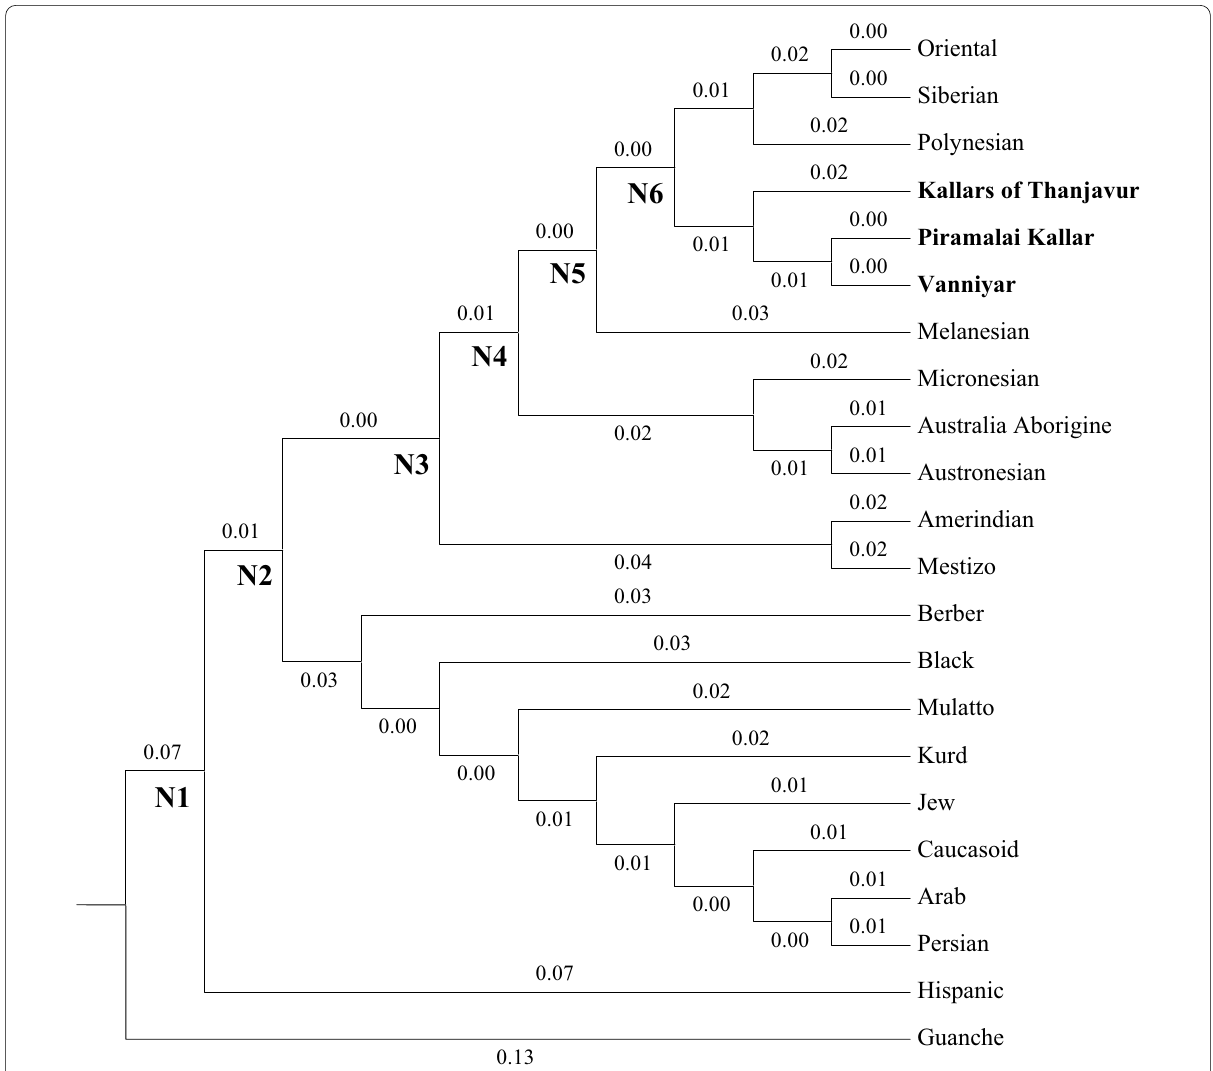
Fig. 1 Neighbor-joining dendrogram showing relatedness between South Indian (Kallars of Thanjavur, Piramalai Kallar and Vanniyar) and other selected global populations. Genetic distances between populations (DA) were calculated using frequencies of HLA-DRB1 alleles. Frequency data for other ethnic populations were from